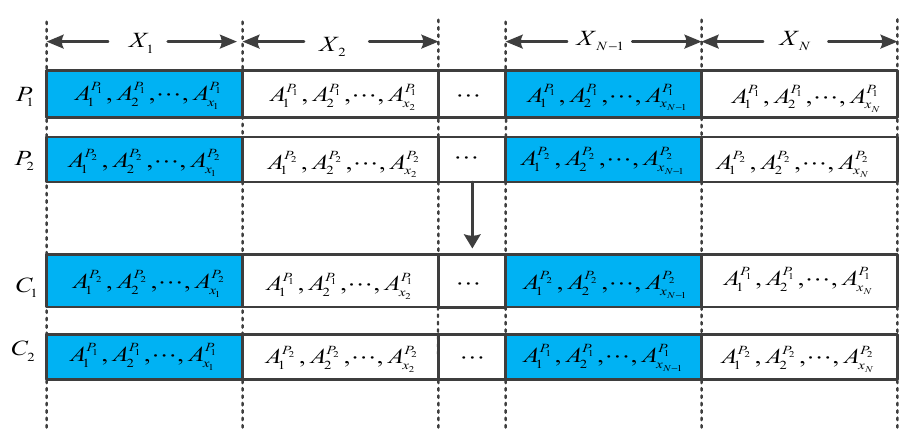
Figure 3. The crossover process case 1 k